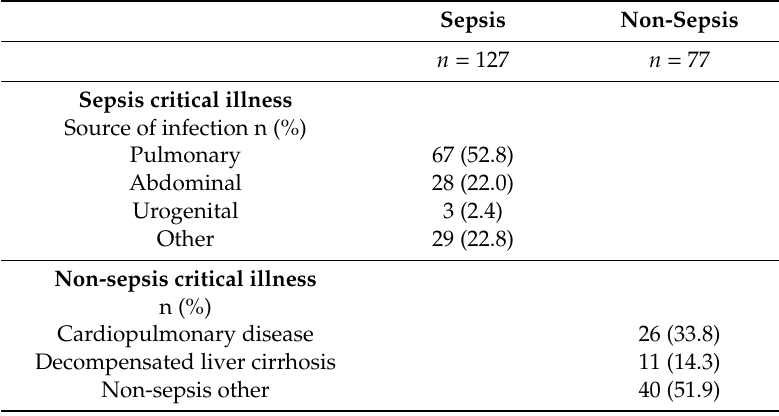
Table 2. Disease etiology of the study